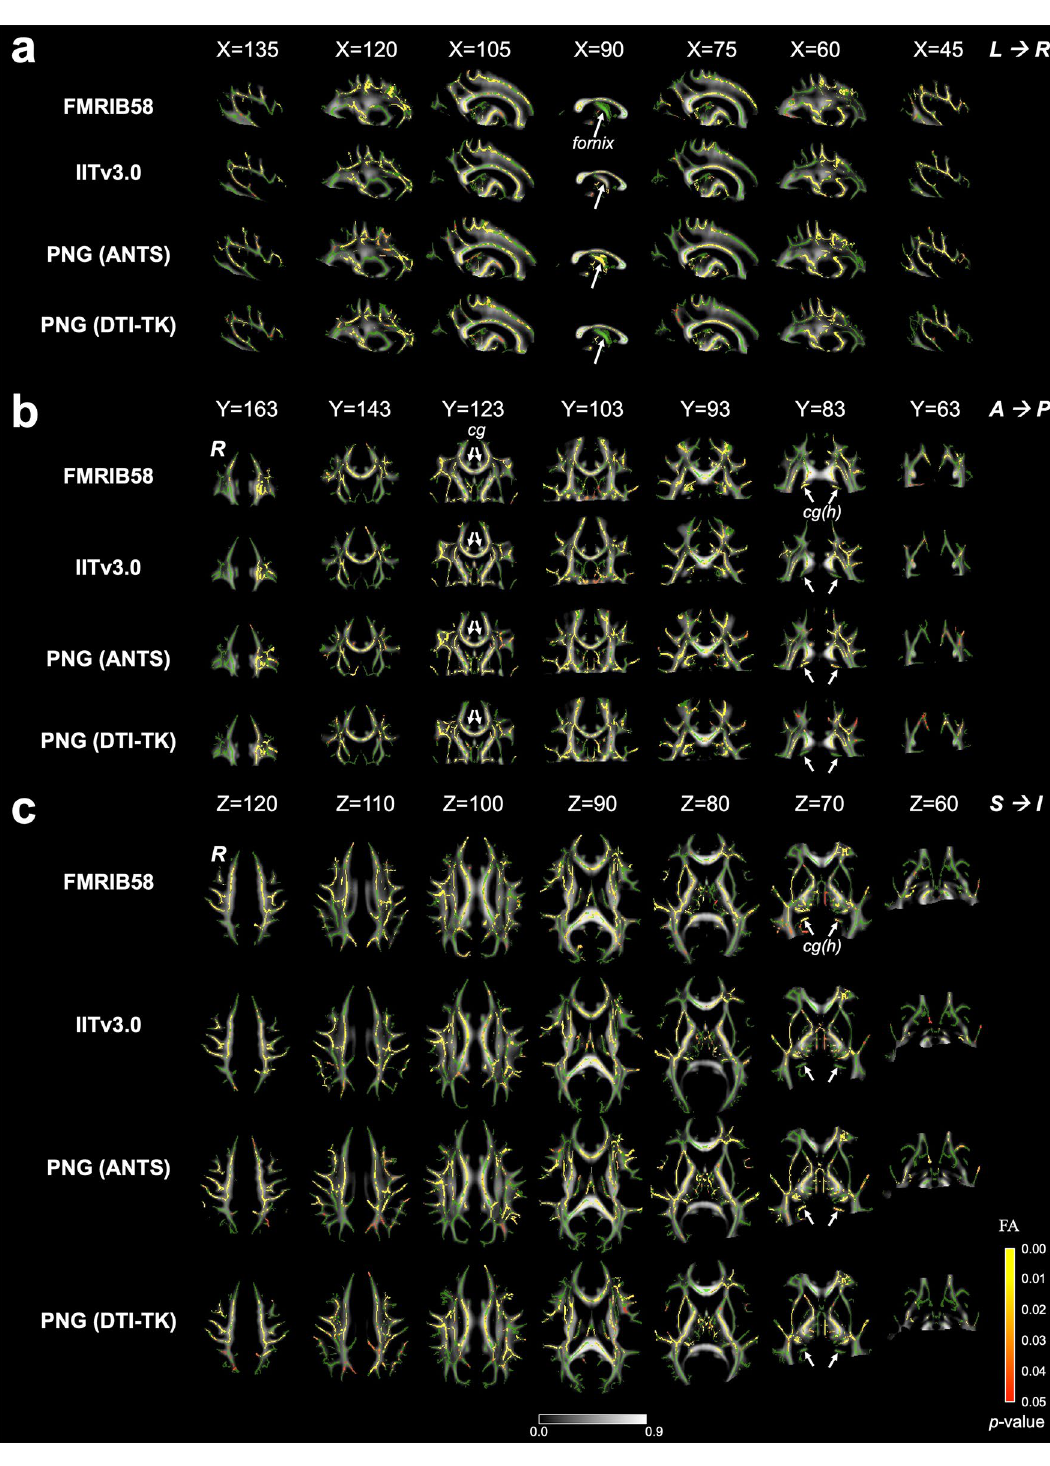
Figure 3. Illustrations of t -statistical maps (red–yellow, FWE corrected, p < 0.05) showing decreased FA at In 2 versus Pre in ( a ) sagittal, ( b ) coronal, and ( c ) axial views, overlaid on TBSS skeleton (green) and mean FA image derived from FMRIB58 (FMRIB, Oxford, UK), IITv3.0 11 , PNG (ANTs), and PNG (DTI-TK) DTI templates respectively. Major white matter tracts showing different sensitivity across the templates for detecting FA changes are highlighted in arrows. cg : cingula. cg(h) : cingula (hippocampi). L/R : left/right hemisphere. A/P : anterior/posterior. S/I :